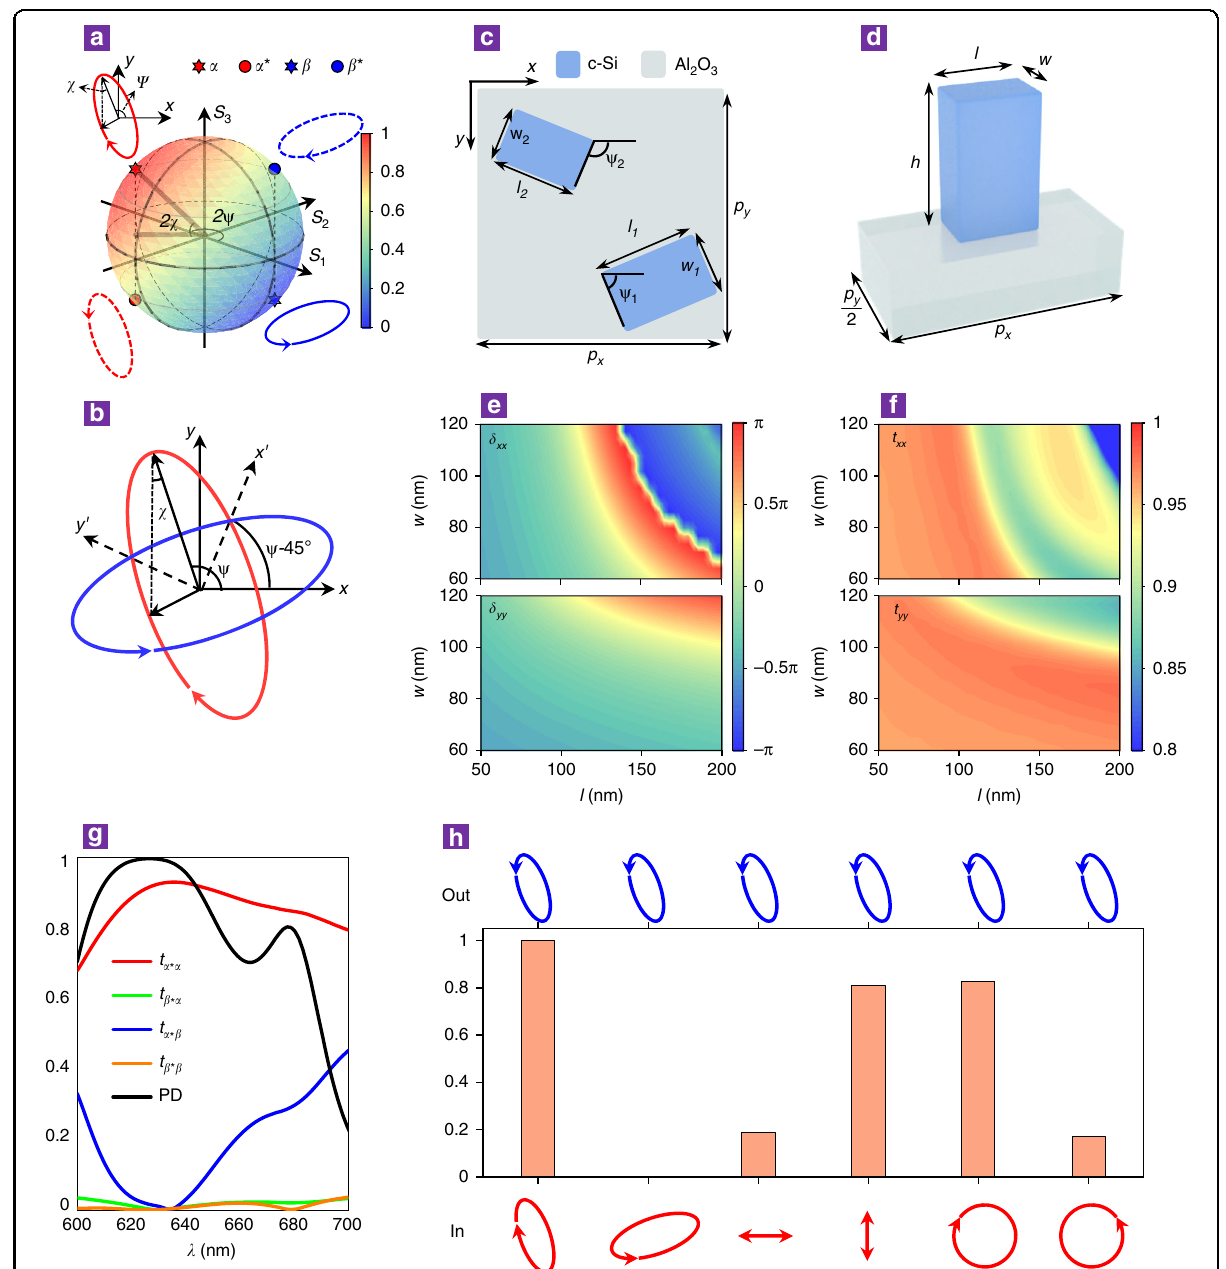
Fig. 2 Metasurface design for APCD. a Poincaré sphere representation of an arbitrary orthogonal polarization pair ( α , β ) (solid red and blue ellipses) and its handedness- fl ipped pair ( α * , β * ) (dashed red and blue ellipses). b De fi ned local coordinate system x ’ oy ’ (dashed lines) that is rotated by ψ -45° with respect to the global xoy coordinate, in which the axes pass through cross points of the polarization ellipses of α and β . c Schematic of metamolecules on the metasurface consisting of asymmetrically dimerized nanopillars. The periods are p x = p y = 340 nm, and the orientation angles and positions of the two nanopillars are ψ 1 = ψ -45° and ψ 2 = ψ and (3 p x /4, 3 p y /4) and ( p x /4, p y /4), respectively, where ψ is the main axis angle of the modulated polarization ellipse. d Single nanopillar unit cell for determining phase retardations along its length and width, as shown in e . The height of the nanopillar was fi xed at 300 nm. e Phase retardations and f transmission coef fi cients upon varying the length l and width w of the nanopillar at a wavelength of 633 nm for the x -polarized (upper panels) and y -polarized (lower panels) incident light. g Polarization conversion coef fi cients and PD spectrum calculated with the optimized parameters ( l 1 = 130 nm, w 1 = 70 nm; l 2 = 150 nm, w 2 = 85 nm) at a wavelength of 633 nm, which yields t α * α = 0.93 and t β * α = t α * β = t β * β ≈ 0. h , Transmitted polarization states (blue ellipses) when the metasurface was illuminated by a variety of different incident polarization states (red curves). The histogram indicates the transmittance, which varied with the incident polarization, while the shape of the blue ellipse was the same as that of the designed polarization state α *